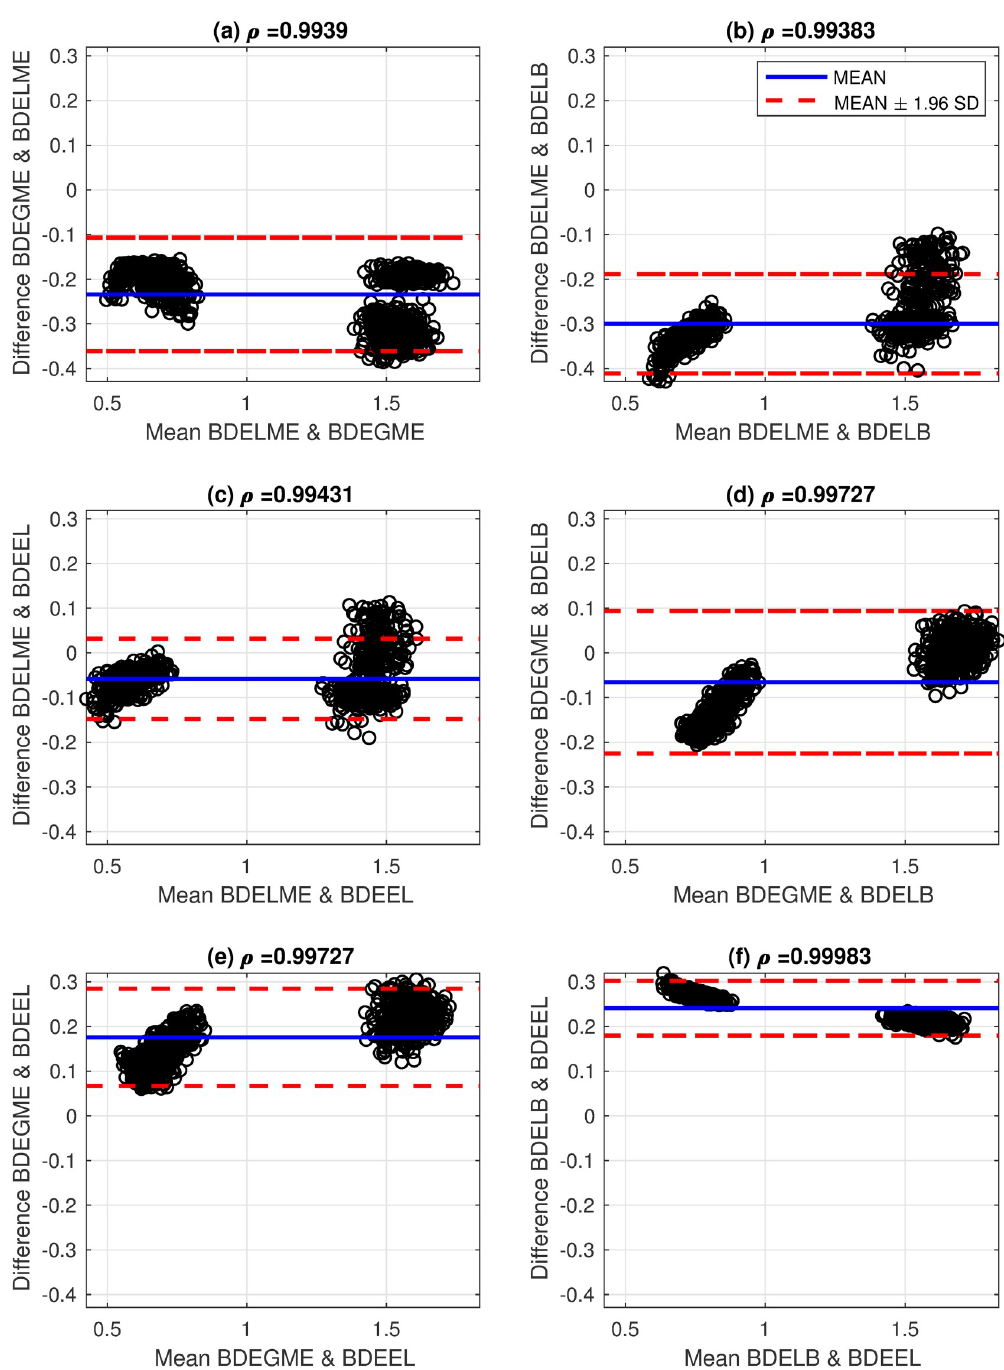
Fig 9. Bland-Altman plots for estimated average lifetimes with fluorescence dyes in channel 1 (390 ± 20 nm) and correlation coefficients: (a) BDELME vs BDEGME, (b) BDELME vs BDELB, (c) BDELME vs BDEEL, (d) BDEGME vs BDELB, (e) BDEGME vs BDEEL, and (f) BDELB vs BDEEL.